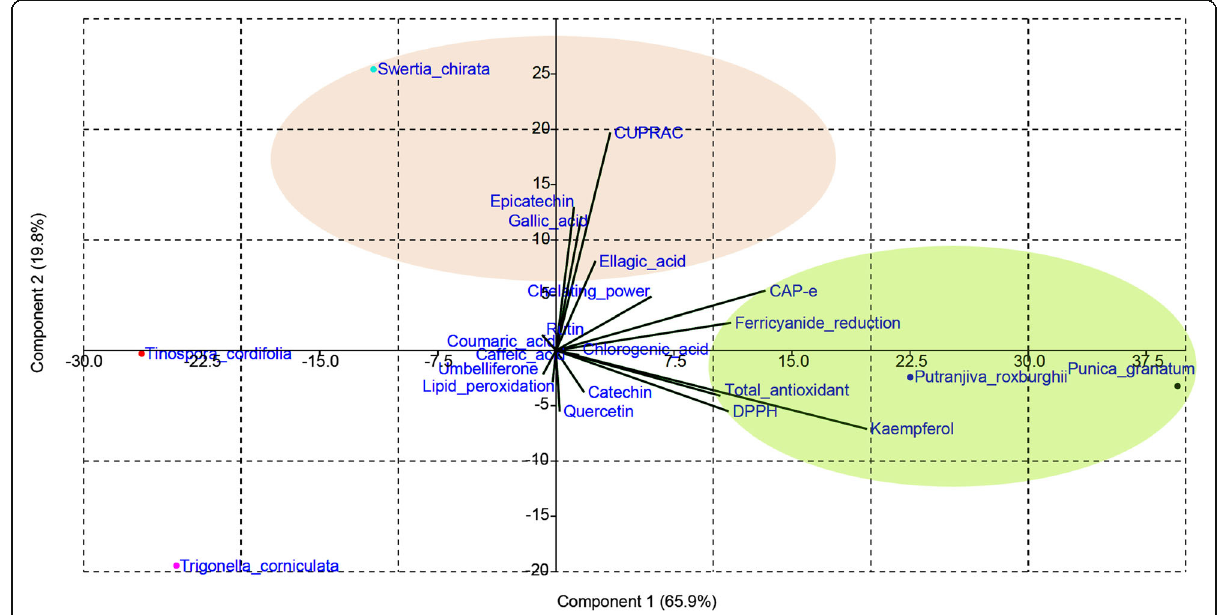
Fig. 2 Reduction of multidimensional variables by Principal Component Analysis (PCA) for five medicinal